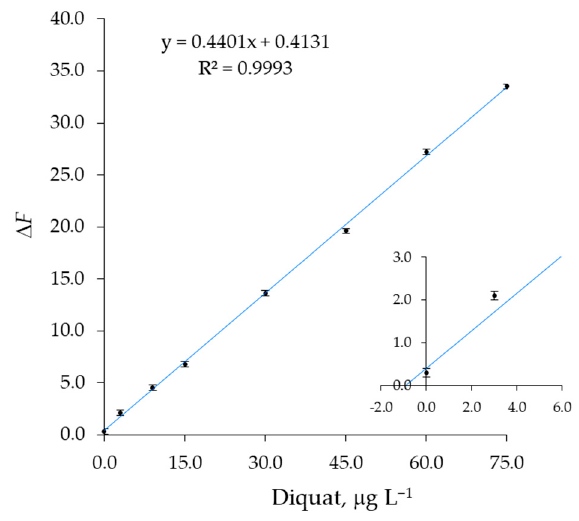
Figure 12. Standard additions plot obtained by adding a methanol solution of diquat, DQ, and 1b to a tap water sample (3 replicates). The sample was divided into 8 equal aliquots. The spike concentration of 1.0 µ g L − 1 was normalized to the total volume of solvent, 60/40 methanol/water. Inset: The straight line intersects the x-axis to the value of (0.9 ± 0.1) µ g L − 1 of diquat. Table 10. Inorganic species detected in the tested sample of tap water and their effect on the determination of herbicide in a solution of these ions with a 10-fold higher